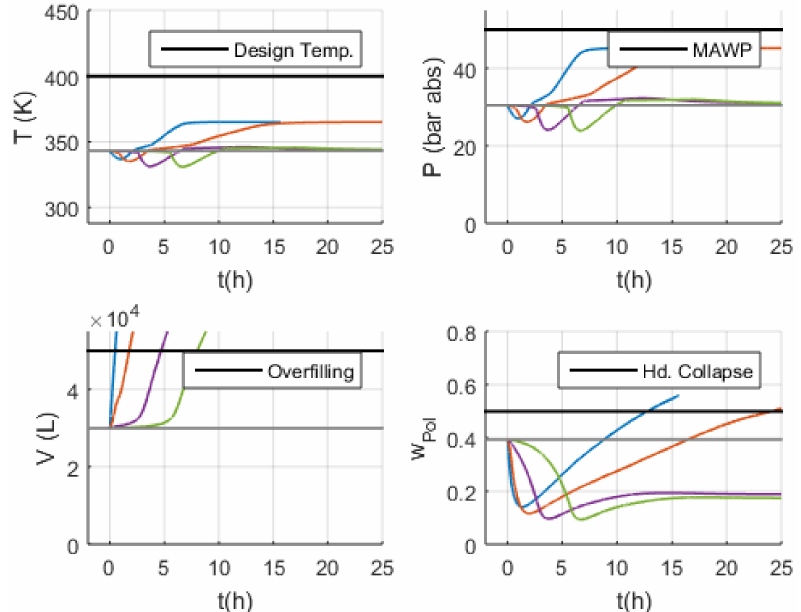
Figure 16. Behavior of critical variables in scenario S-3 with Model 1. Make-up flow: ( ) maximum flow; ( ) 150% of normal flow; ( ) 110% of normal flow; ( ) 101% of normal flow; ( )